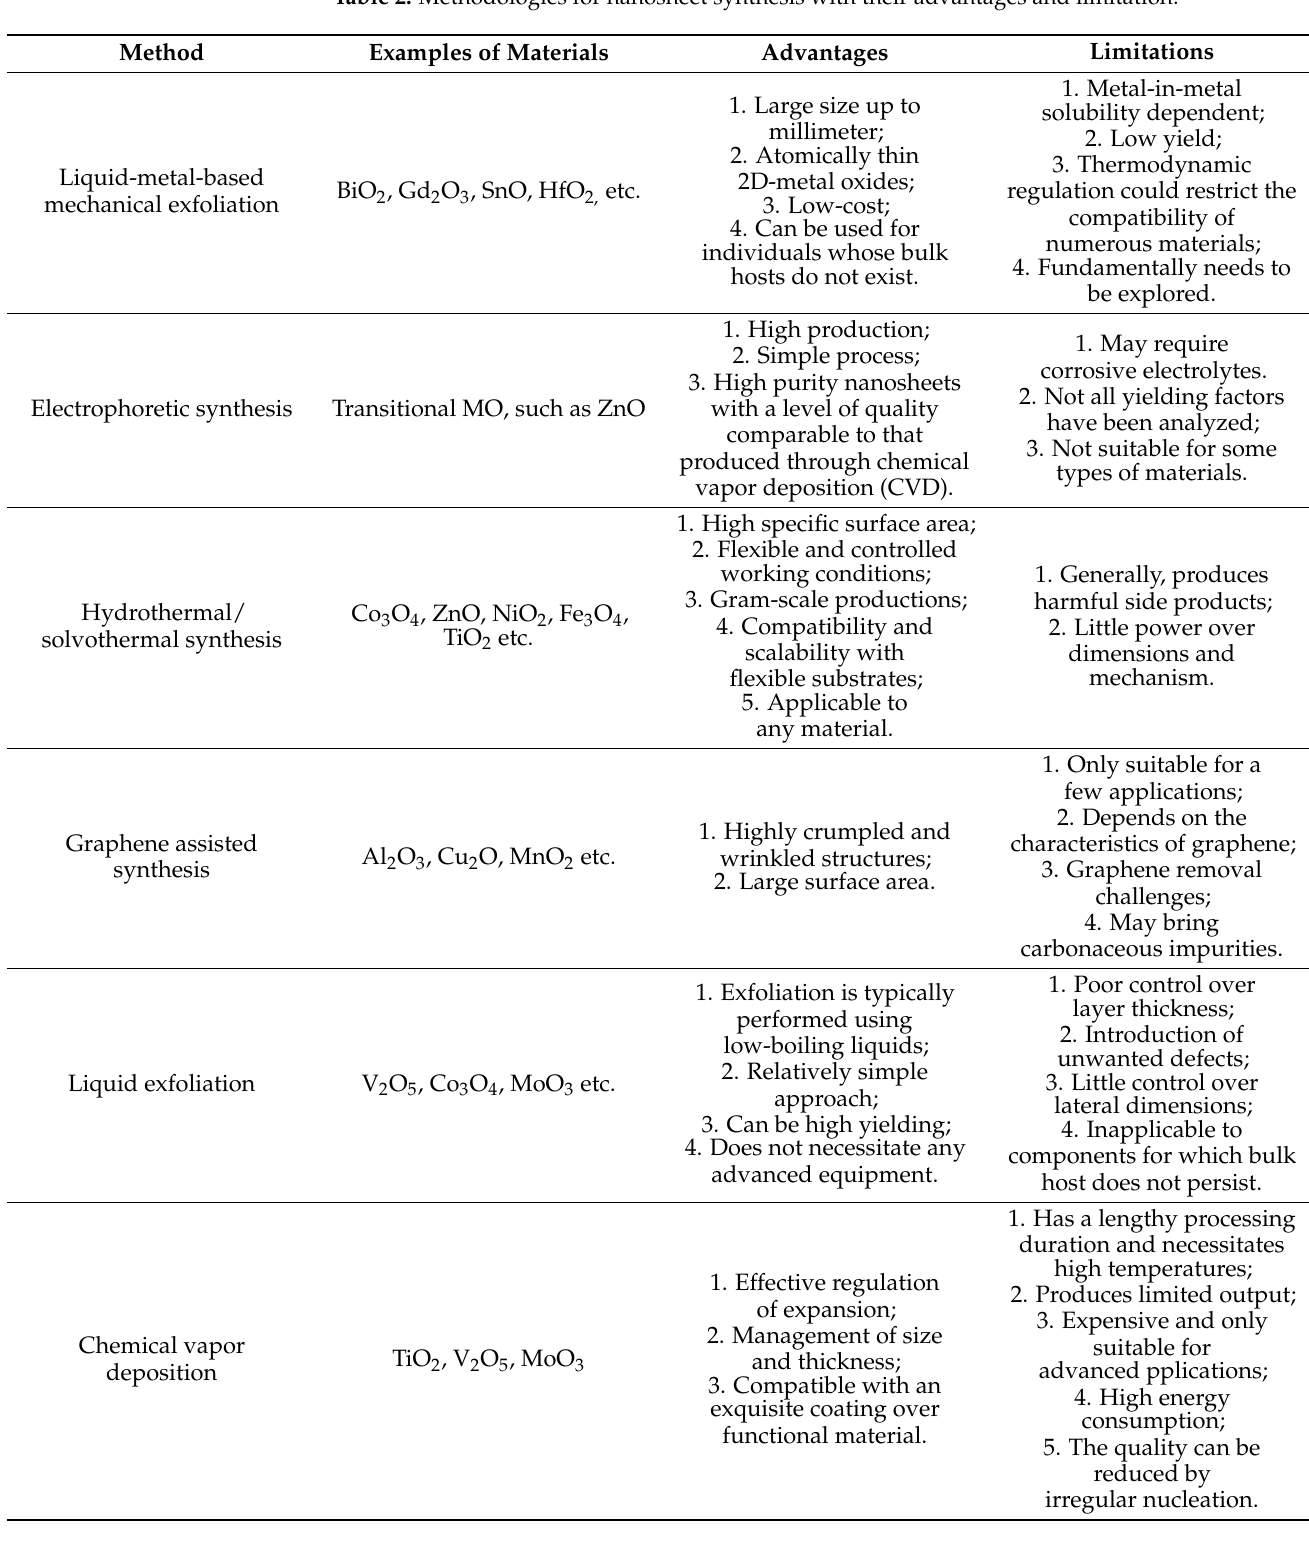
Table 2. Methodologies for nanosheet synthesis with their advantages and